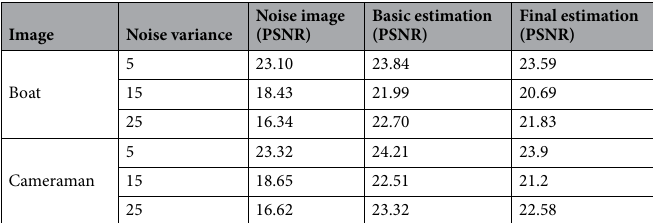
Table 2. The denoising results at each stage of BM3D.